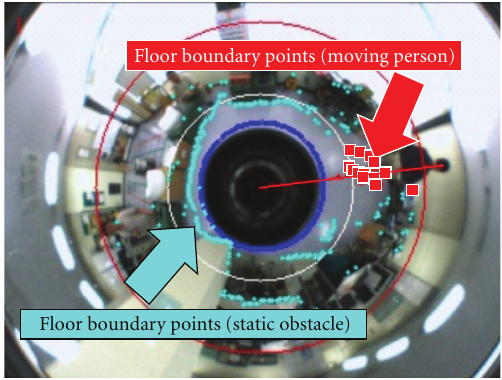
Figure 7: The output of classification